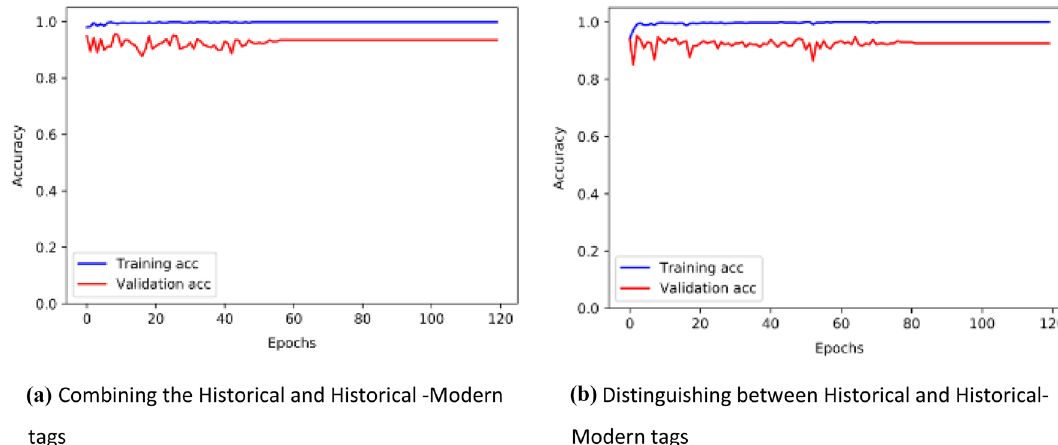
Fig. 13 Object detection network experiment process Table 1 Test results of image classification network